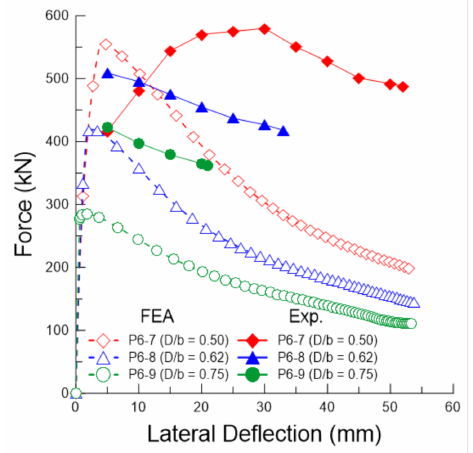
Figure 10. Force–lateral deflection curve of perforated plates.